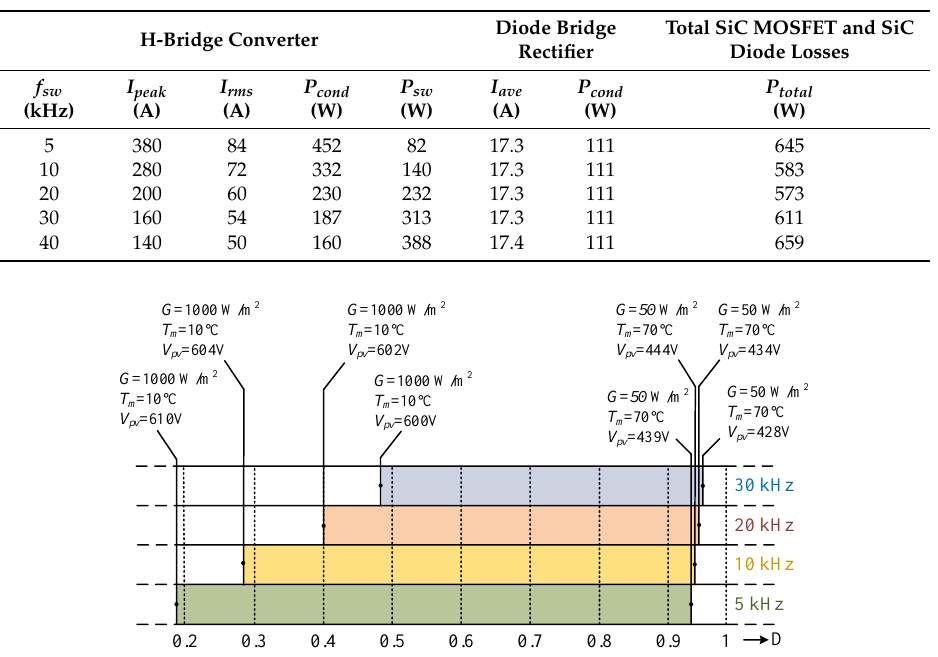
Table 3. Power semiconductor losses in MPPT converter against switching frequency (Operating